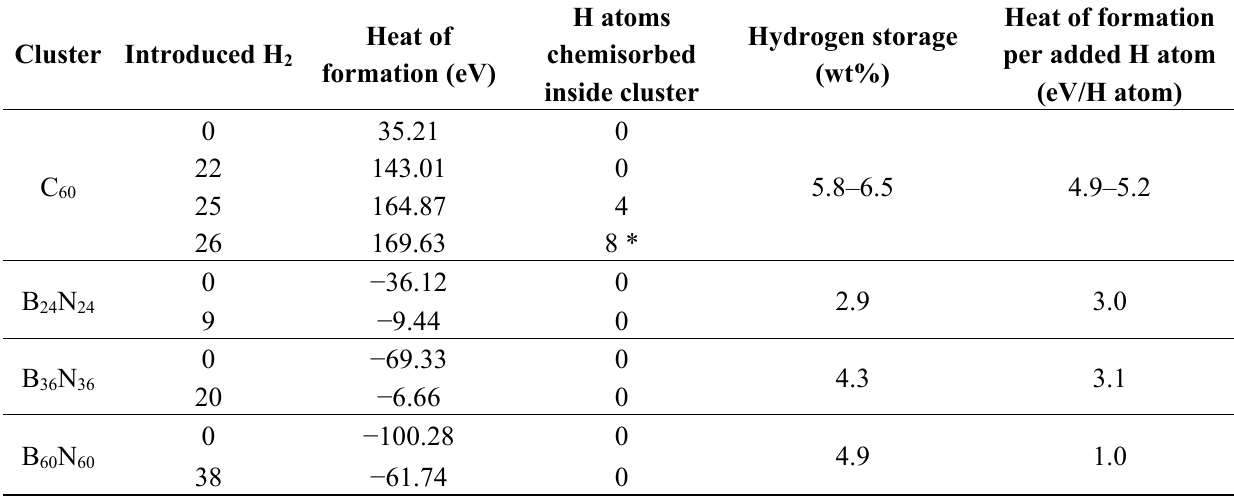
Table 4. Energy of clusters with